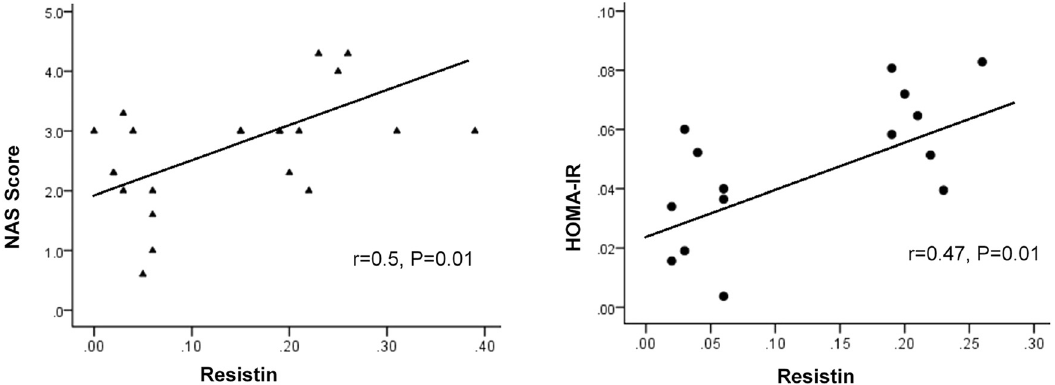
Figure 2: Correlation of serum resistin levels with NASs and HOMA - IR in the rat model of NAFLD. Pearson ’ s correlation coe ffi cients after adjustment for weight are shown. Serum resistin levels had signi fi cant correlations with NASs and HOMA - IR. However, serum visfatin levels had no signi fi cant correlations with NASs and HOMA - IR. Abbreviations: NASs, NAFLD activity scores; HOMA - IR, homeostasis model assessment of insulin